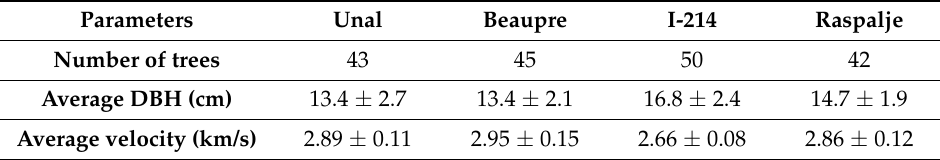
Figure 7. Propagation velocity versus DBH for the different clones of Plantation 2; Unal (orange square); Beaupre (blue circle); I-214 (black triangle); and Raspalje (red diamond). Table 3. Number of trees, average values, and standard deviation of DBH and propagation velocity for each poplar clone.